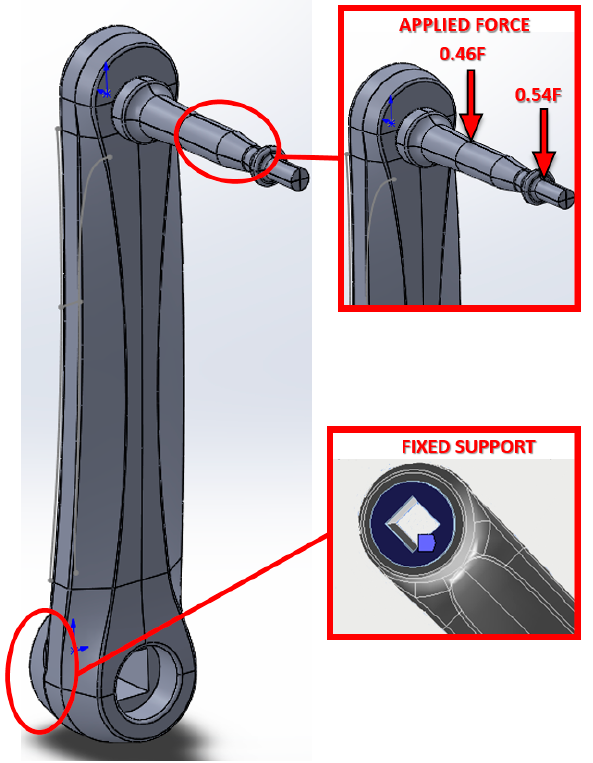
Figure 2. Finite element crank and pedal model. Applied force detail. Fixed Support contour bound- ary.